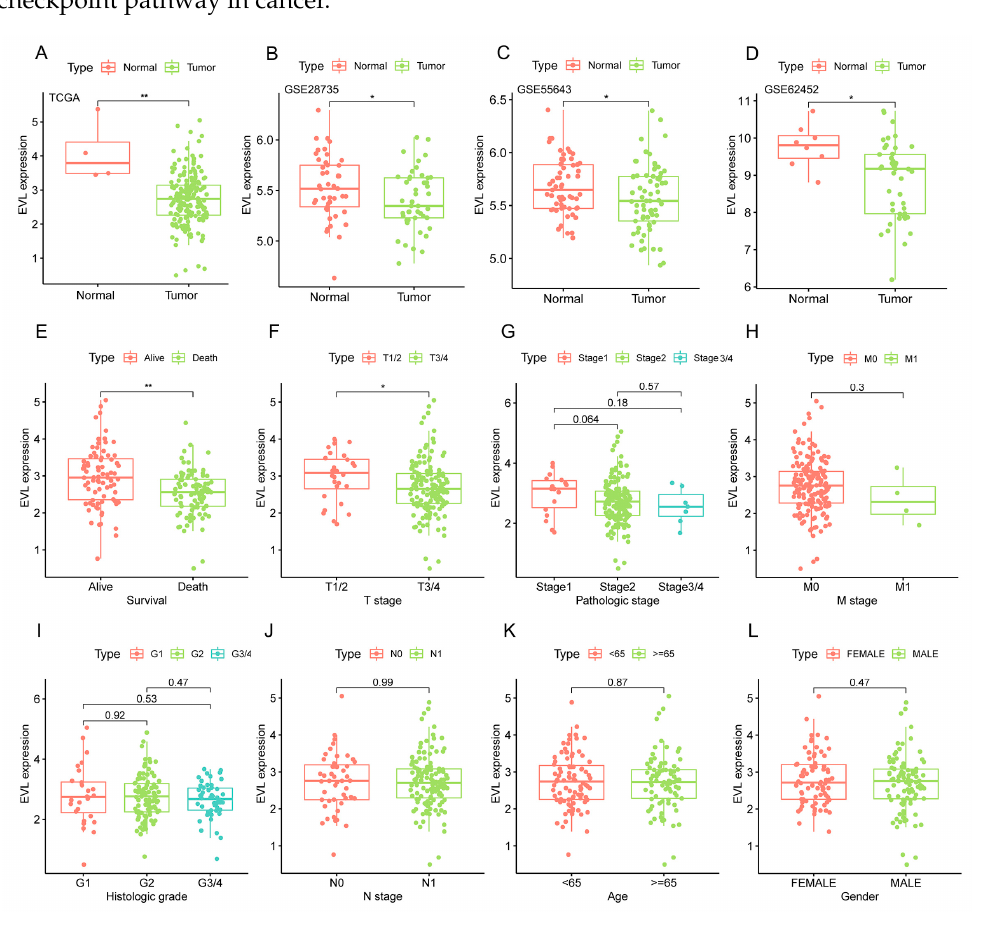
Figure 2. Comprehensive enrichment analysis associated with EVL. ( A ) EVL pan-cancer analysis in 33 types of tumors. ( B,C ) GO and KEGG analysis based on EVL co-expressed genes. ( D ) DEGs